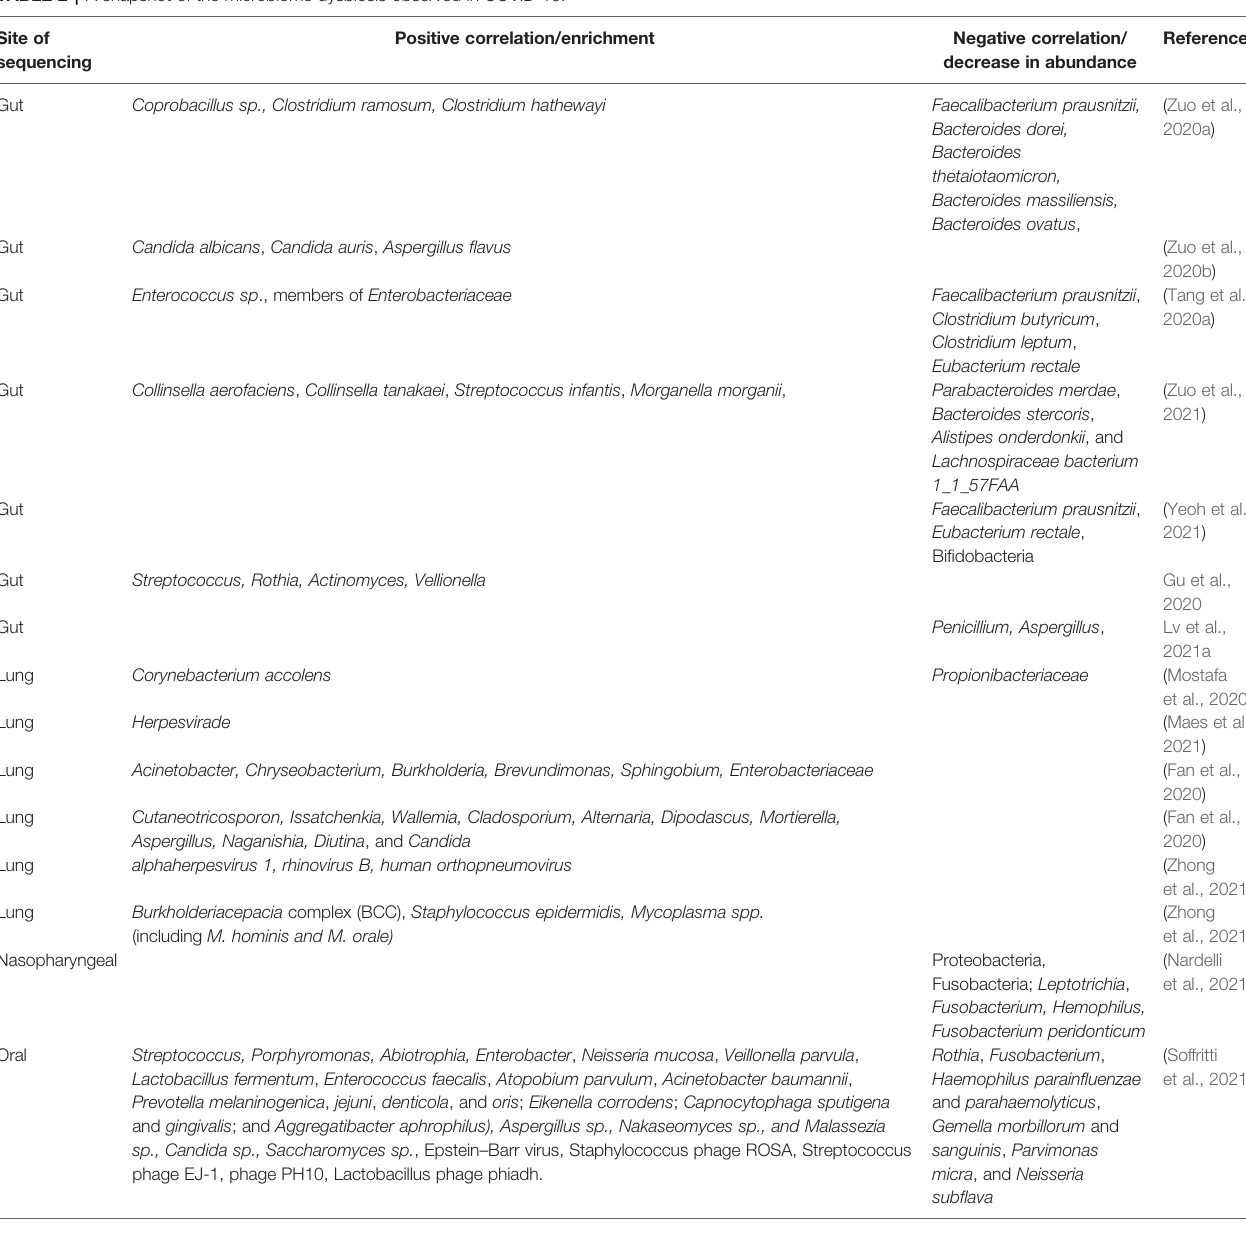
TABLE 2 | A snapshot of the microbiome dysbiosis observed in